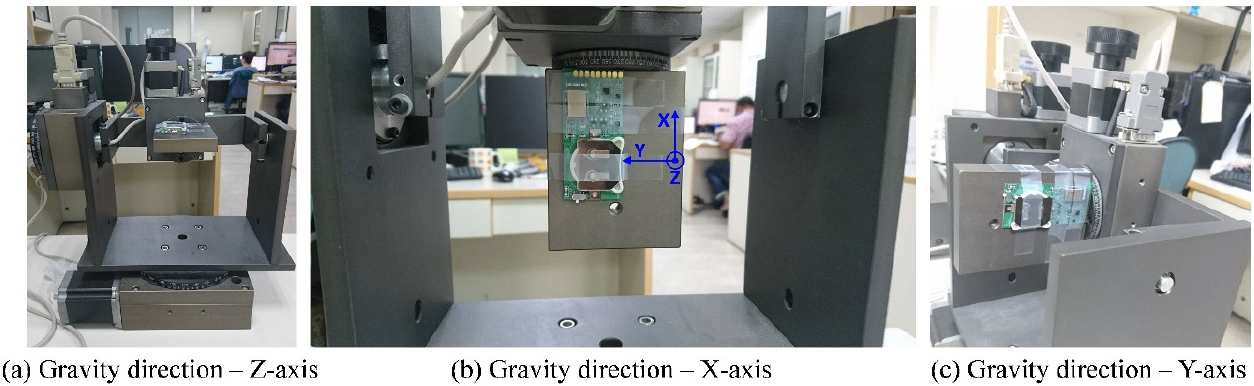
Figure 6. BASIC module calibration processes: ( a ) gravitational force direction— z -axis; ( b ) gravitational force direction— x -axis; ( c ) gravitational force direction— y -axis.